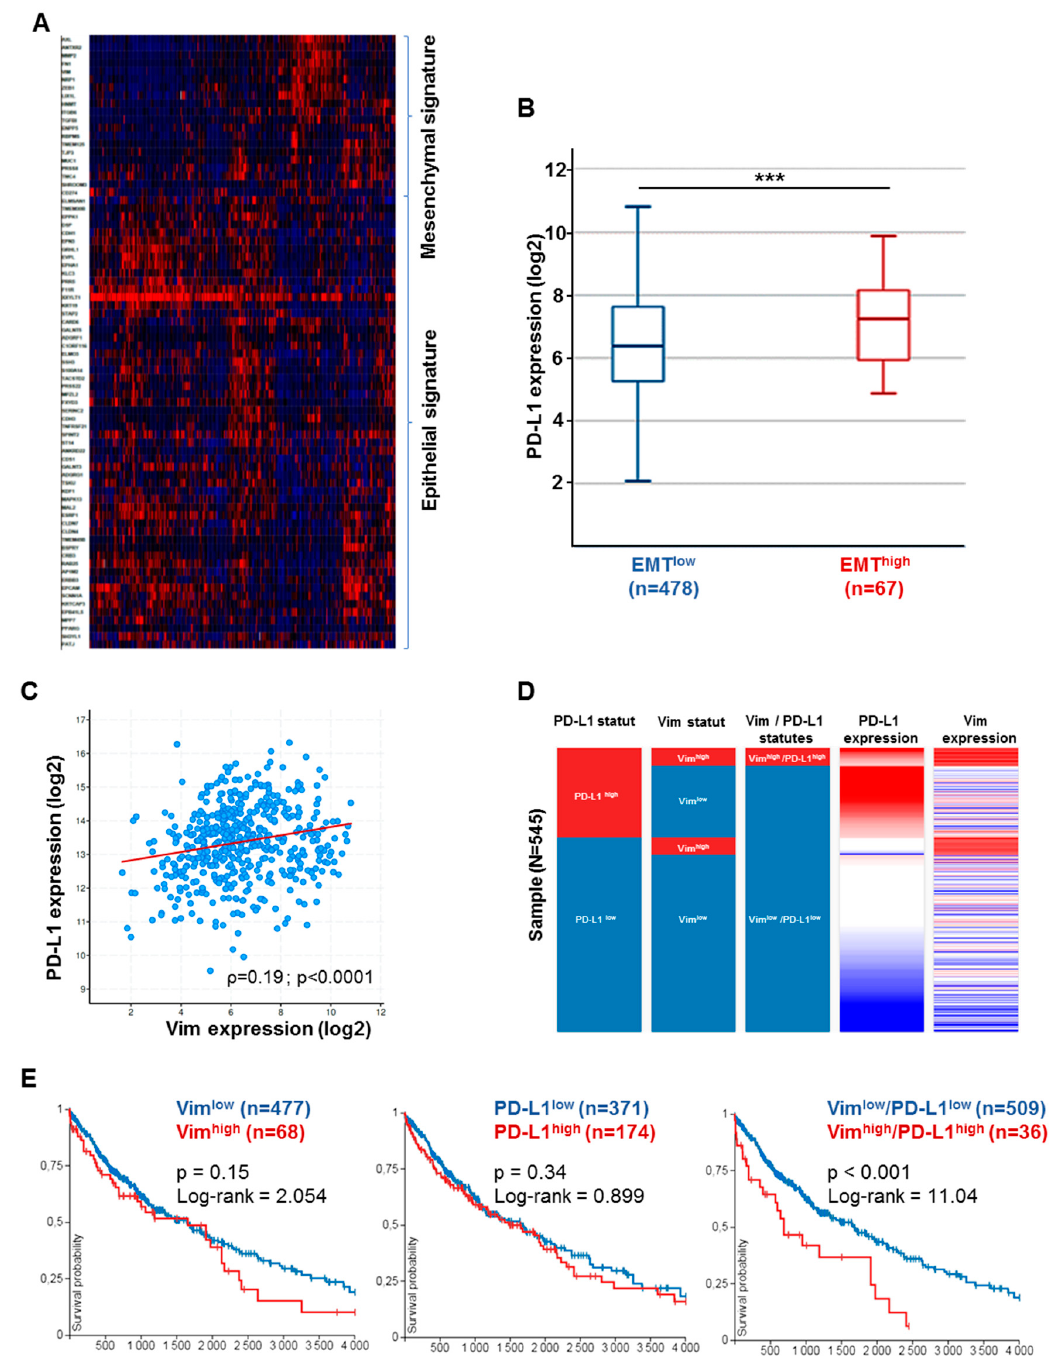
Figure 4. The epithelial–mesenchymal transition signature correlates with PD–L1 expression in Tumor Cancer Genome Atlas Lung Squamous Cell Carcinoma (TCGA–LUSC) cohort. ( A ) Heat map showing the di ff erential gene expression by epithelial–mesenchymal features in TCGA–LUSC cohort. ( B ) PD–L1 expression is higher in mesenchymal-types tumors. Tumors with epithelial phenotype (EMT low ) ( n = 478) expressed lower mRNA CD274 level than tumors with mesenchymal features (EMT high ) ( n = 67). *** p < 0.0001. ( C ) PD–L1 correlates with vimentin expression in TCGA cohort. Data are showed with dot-plots with log2 scale and analyzed with spearman regression test. ( D ) Tumors’ repartition in LUSC cohort according to PD–L1 and / or vimentin status. ( E ) Survival analysis according to vimentin, PD–L1 expressions and both Vim / PD–L1 co-expression. Overall survival probability by time (days) represented with Kaplan–Meier curves.